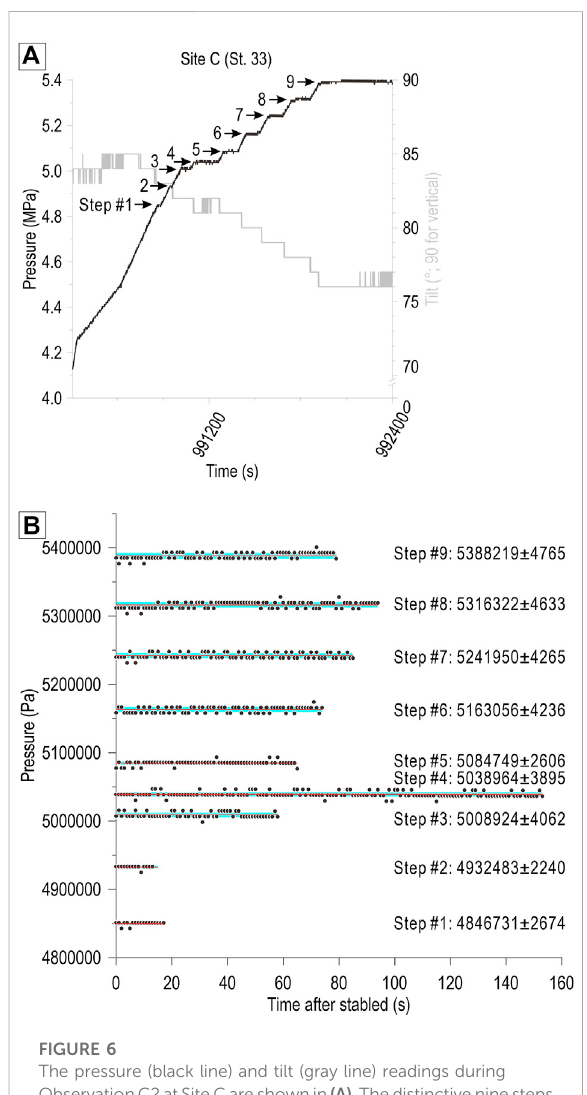
FIGURE 6 The pressure (black line) and tilt (gray line) readings during ObservationC2atSiteCareshownin (A) .Thedistinctiveninesteps in pressure reading (Steps #1 to #9) are a consequence of a cable increment between those steps: all 5 m increment except 2 m between #3 – 4 and 3 m between #4 – 5. The tilt readings change slightly from 83 to 76 during the experiment. The pressure reading(blackdots)foreachstepisdisplayedin (B) withanaverage (red line) and standard error (blue shadow). The pressure changes between steps (Table 2) correspond to the weight of the sediment column with the height of a cable increment. See the